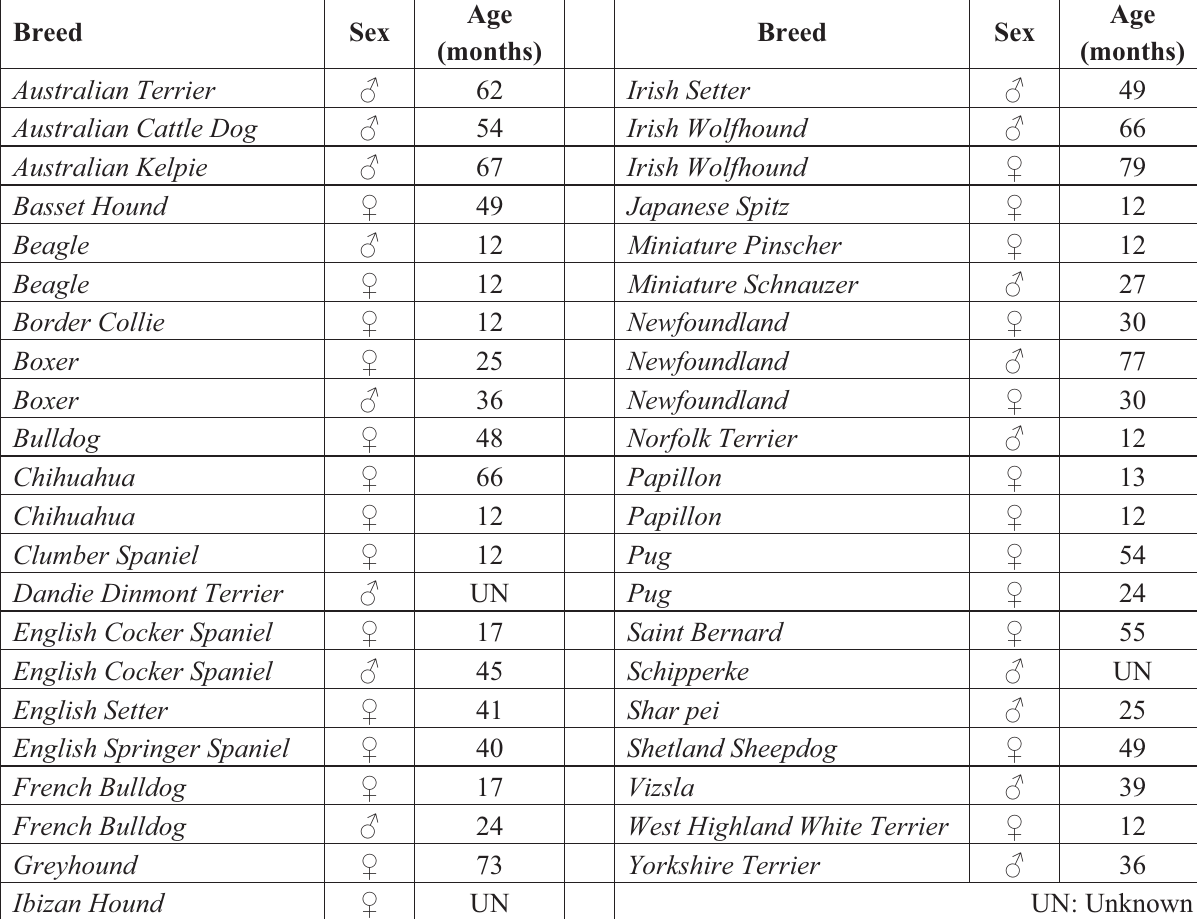
Table 1. Characteristics of dogs (Canis familiaris ) used in the present study.